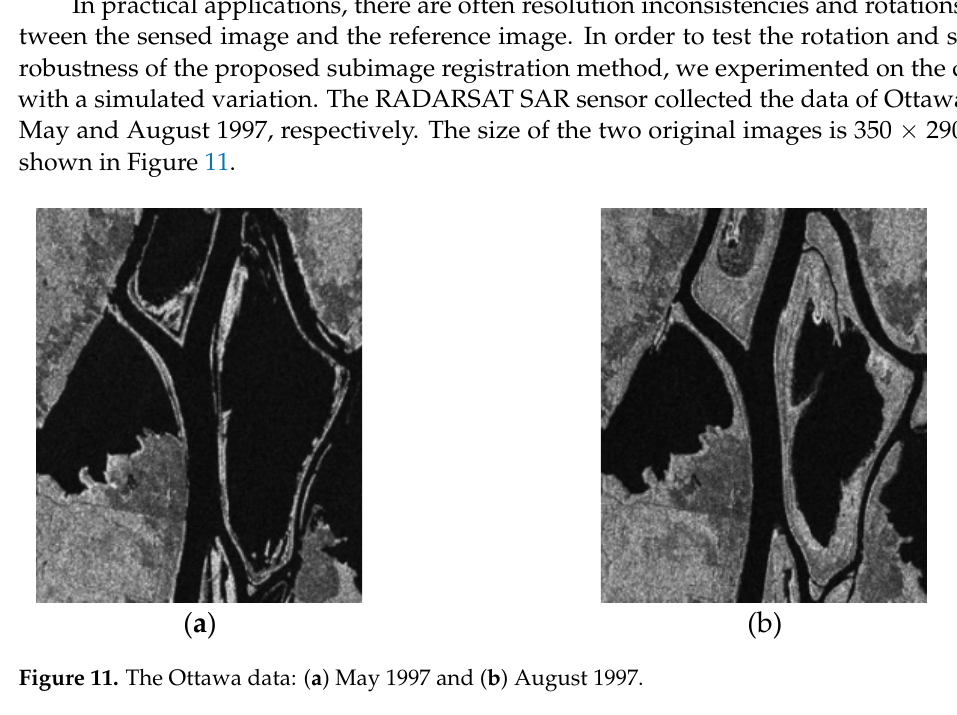
Figure 12. The registration performance of SAR images at varying rotations: ( a ) –15°, ( b ) –10°, ( c ) –5°, ( d ) 5°, ( e ) 10°, and ( f ) 15°.